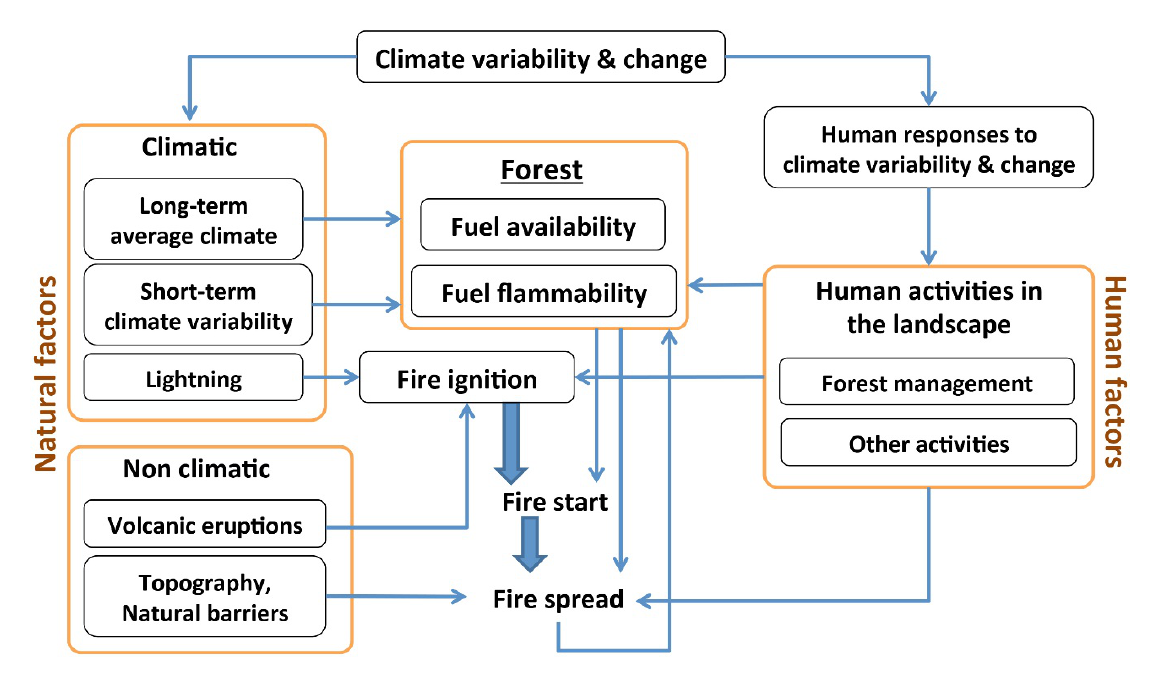
Figure 1. Fire factors and possible impacts of climate variability and change on forest